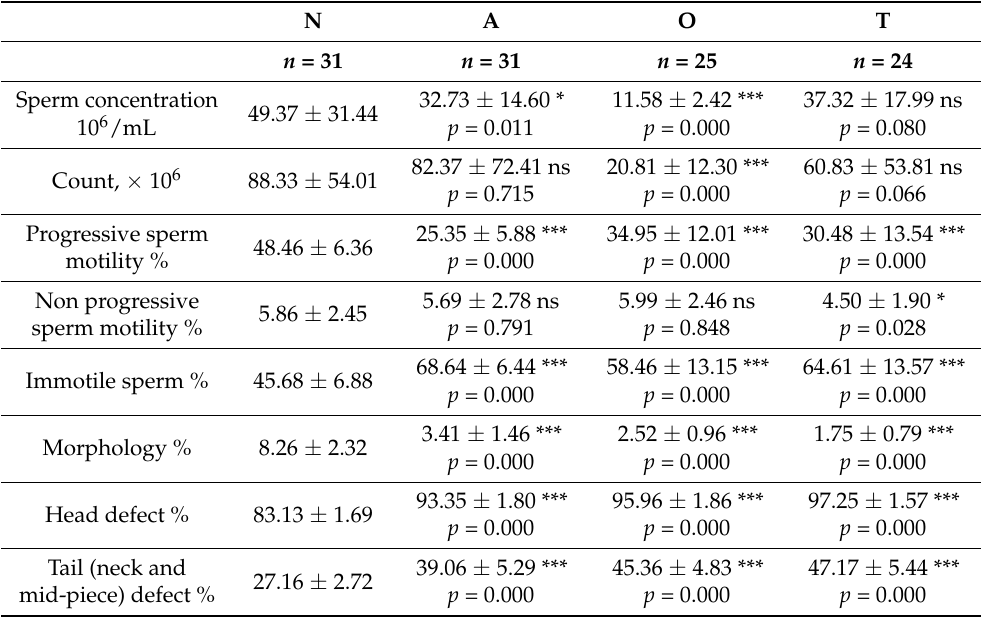
Table 1. Semen analysis and the main sperm characteristics in normosperminc (N) and infertile